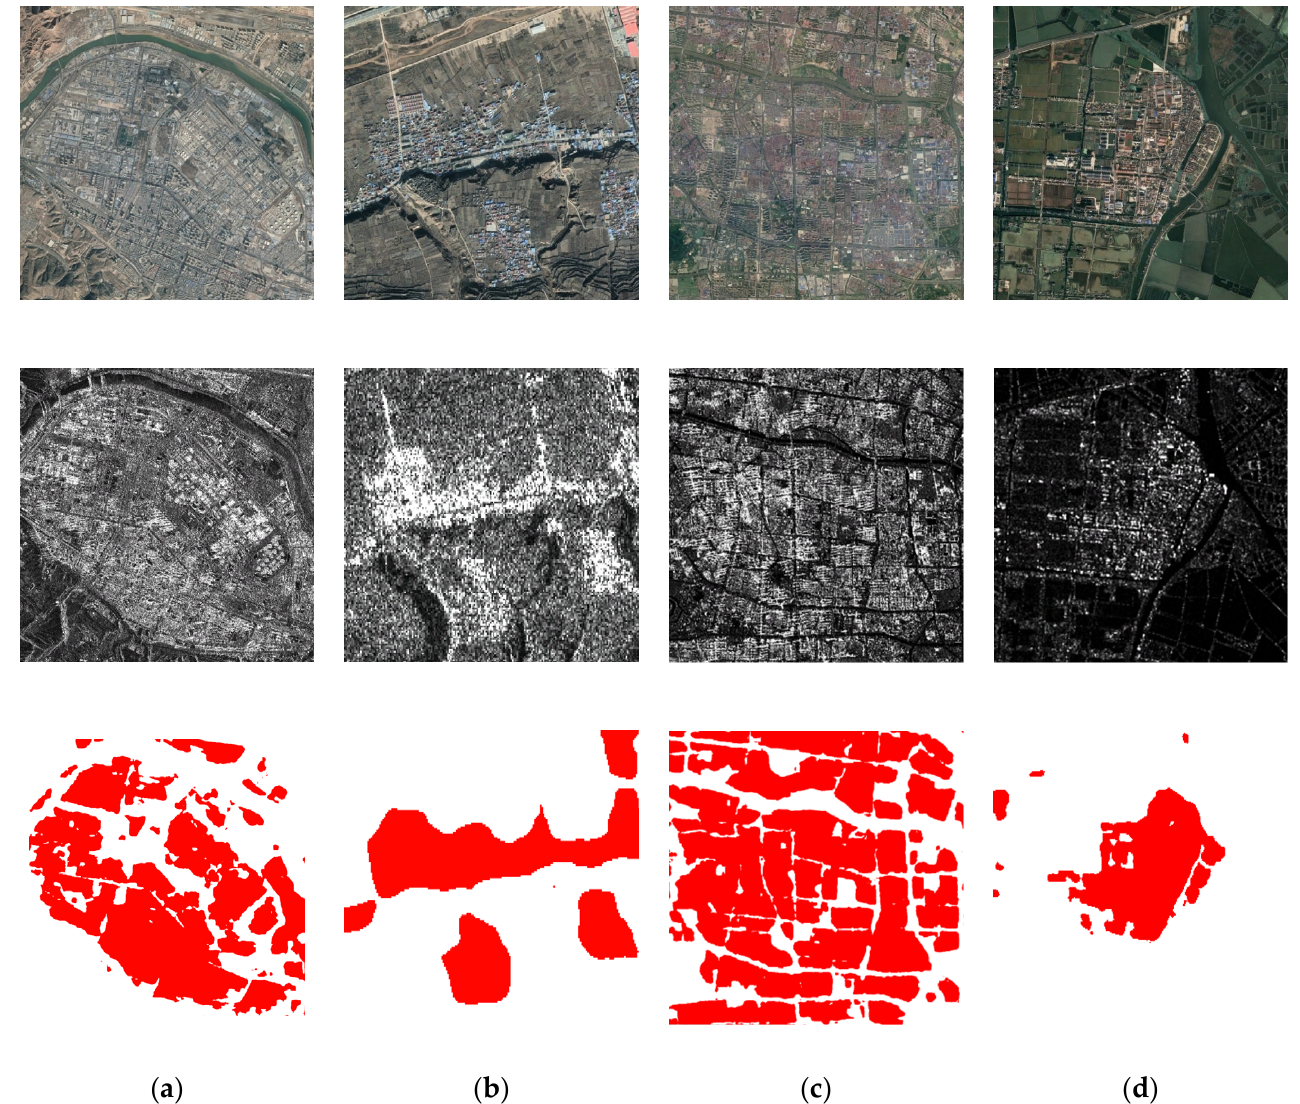
Figure 11. Google Earth images, SAR images, and BAs of the two provinces: ( a ) Urban area in Gansu, ( b ) village area in Gansu, ( c ) urban area in Jiangsu, and ( d ) village area in Jiangsu.